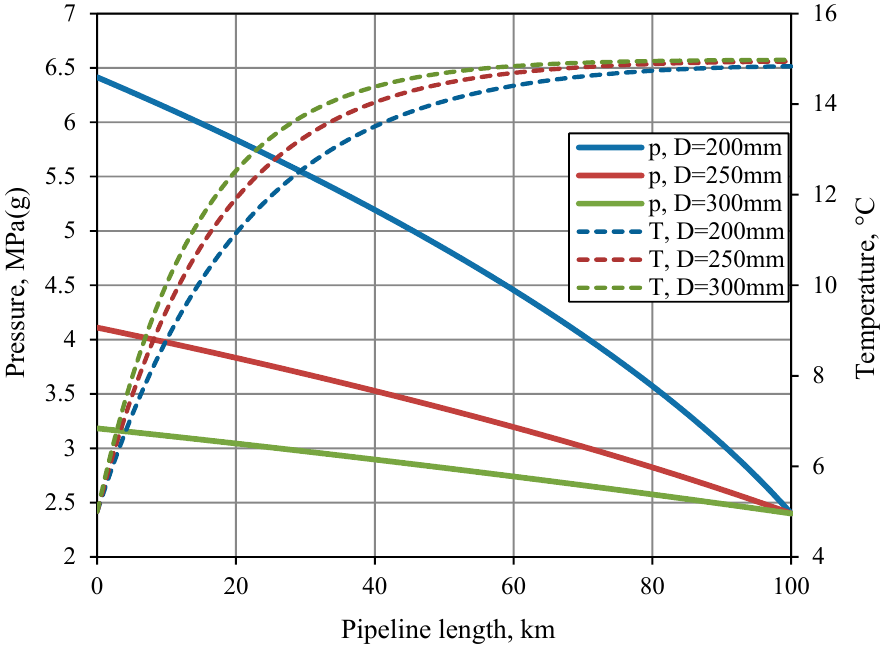
Figure 8 . Pressure ( p ) (continuous lines) and temperature ( T ) (dashed lines) changes for hydrogen mass flow rate of 2.0 kg/s (80,000 Nm 3 /h) for different diameters.